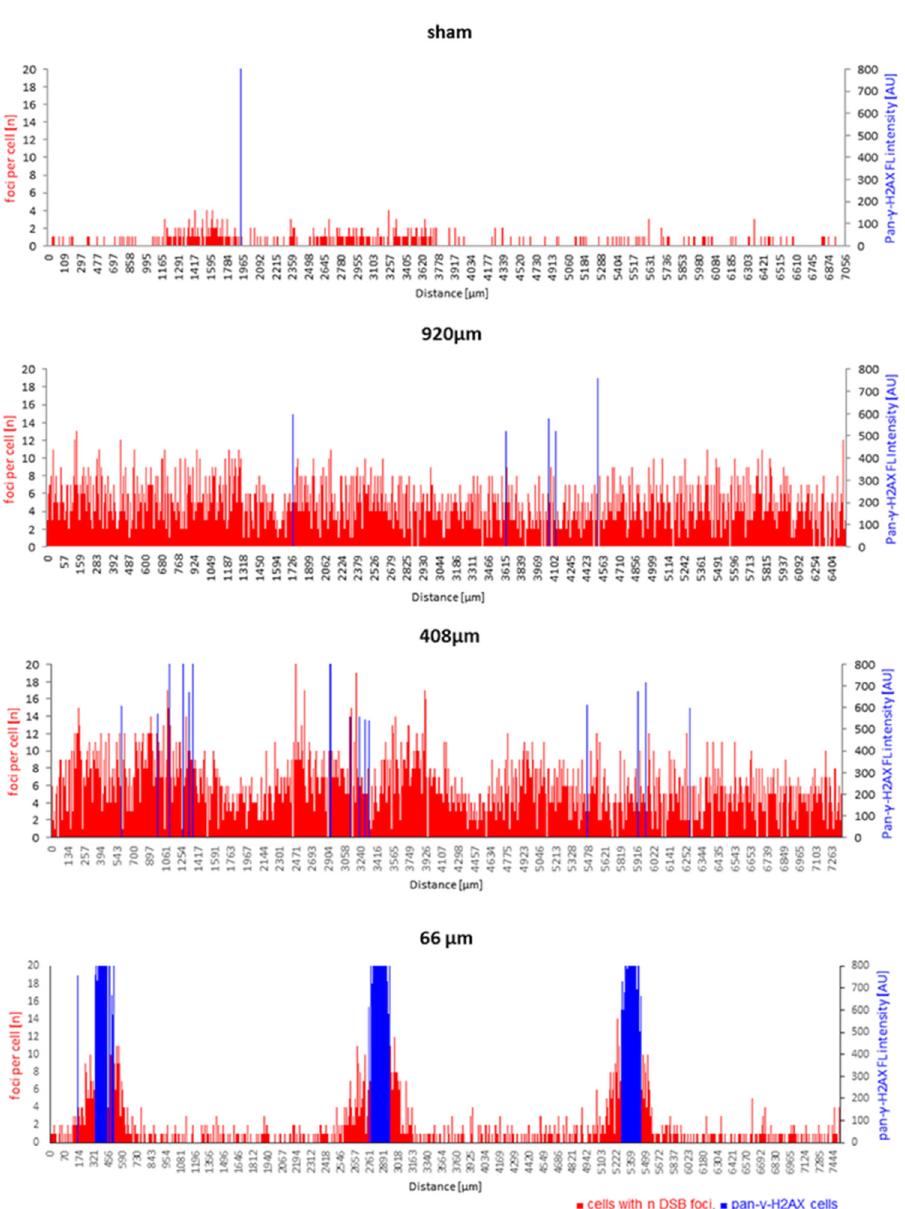
Figure 6. Spatial DNA damage distribution responds to beam width across proton minibeam- irradiated epidermides. The positions of cells with their respective DSB focus number (red bars) are shown along the length of the respective tissue cross-section. The height of each red bar corresponds to the number of foci within a spatially annotated cell, while the height of the blue bars indicates the position of each pan- γ -H2AX cell nucleus and its fluorescence intensity (arbitrary intensity units, AU) along a model cross-section. Sham irradiation: There is a low density of nuclei with 53BP1 DSB foci across the tissue, with most such cells having one or two DSB foci. Wide-field minibeam irradiation (920 µ m): all cells show several DSB foci (up to 12) per nucleus; 408 µ m minibeam irradiation: nearly all cells display DSB damage foci with regional fluctuations, while a few blue pan- γ -H2AX cells are seen; 66 µ m minibeam irradiation: sharply localized clusters of cells displaying pan- γ -H2AX nuclei at the dose peaks are flanked by cells showing elevated DSB foci numbers. The distance of the peaks of pan- γ -H2AX cells corresponds to the inter-beam distances of 2500 µ m. Damage in the interstitial tissue corresponds to sham-irradiated